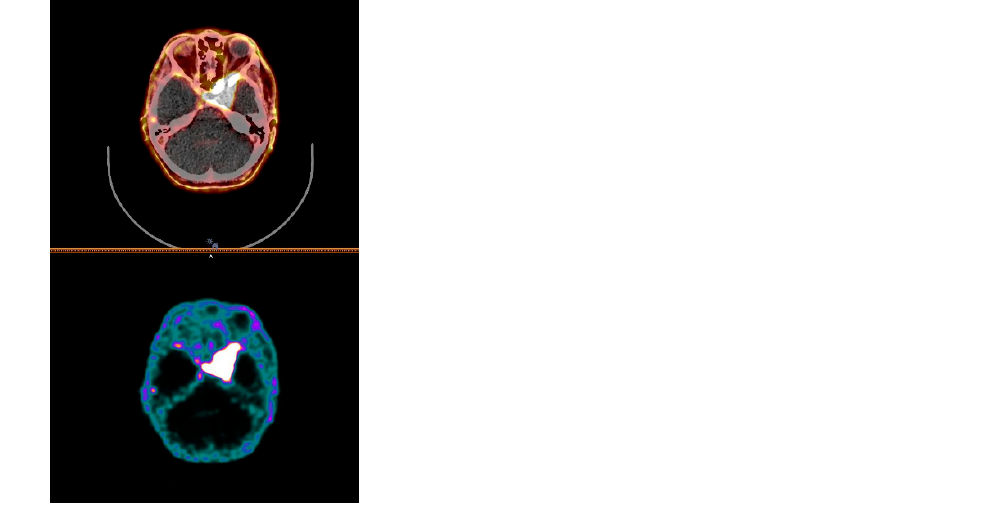
Figure 5. [ 64 Cu]Cu-DOTA-TOC PET/CT: A 44-year-old gentlewoman with recurrent meningioma of the skull base; fused image ( top row ) and PET image ( bottom row ) illustrates left sphenoidal body and ala tumor involvement.